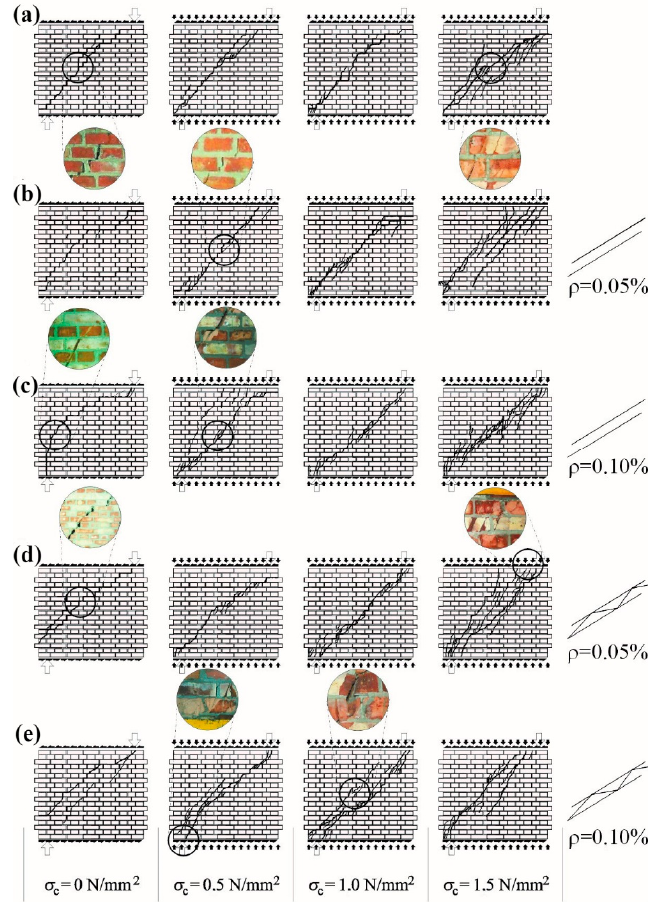
Figure 7. Patterns of cracking clay brick masonry walls: (a) unreinforced walls, (b) walls reinforced with bars ρ = 0.05%, (c) walls reinforced with bars ρ = 0.10%, (d) walls reinforced with trusses ρ = 0.05%, and (e) walls reinforced with trusses ρ = 0.10%.